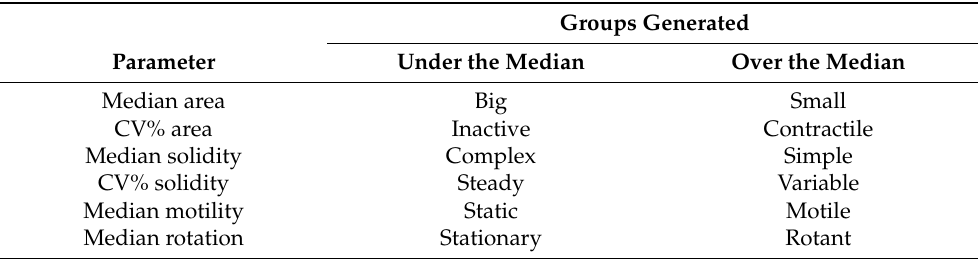
Table 1. For each parameter, using the median as a cut-off, we generated two groups named as reported in the table. Therefore, a microglial cell is included in one or the other group according to the value of the descriptor if it is bigger or lower with respect to the median value. Groups Generated Parameter Under the Median Over the Median Median area Big Small CV% area Inactive Contractile Median solidity Complex Simple CV% solidity Steady Variable Median motility Static Motile Median rotation Stationary